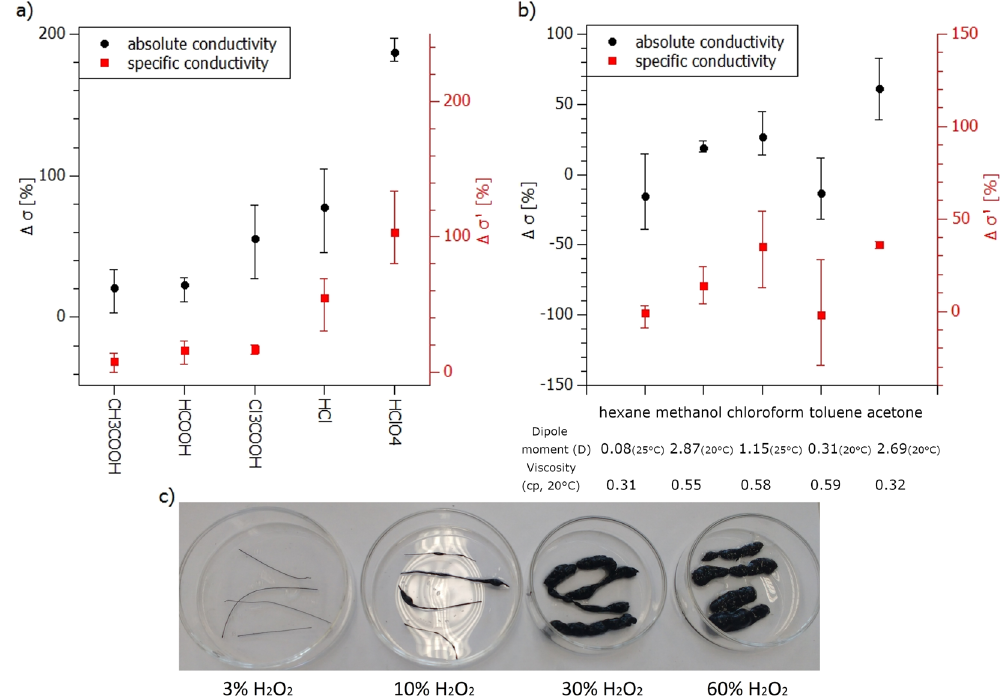
Figure 1. Average conductivity change obtained after treating CNT fiber with ( a ) acids of various acidity (K a in water), ( b ) different organic solvents after pre-annealing. Whiskers represent differences between maximum and minimum values obtained in a series of experiments conducted; ( c ) A photograph illustrating swelling of fibers caused by different H 2 O 2